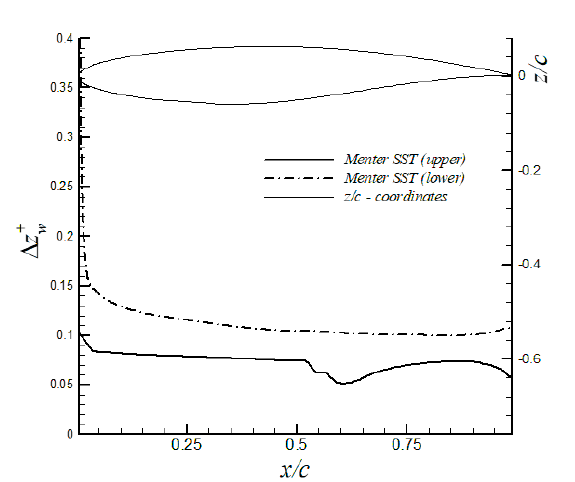
Figure 6. Distance distribution of the first off-wall point in wall units along the RAE airfoil for the Menter SST model.